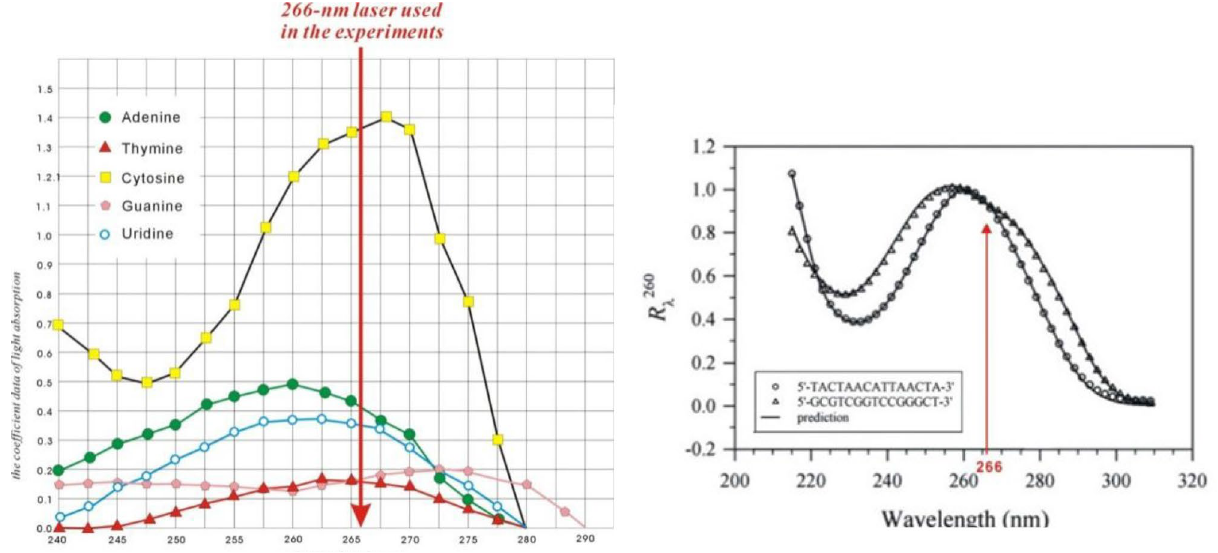
Figure 1. Absorption spectra of nucleotides and comparison of predicted (solid lines) and experimentally measured (symbols) spectra for double and single-stranded DNA oligomers. The left part of the figure, the x-axis shows the wavelength in nm and the y-axis shows the coefficient data of light absorption. The light from the 266-nm laser is indicated with a red arrow and presented in the nucleotide absorption spectrum. The image is from the assay of the absorption spectra of 50 μM/L of each nucleotide. The right part of the figure, the GC content in the sequences is 20% (open circle) and 80% (open triangle). The image was modified from Tataurov et al. 3